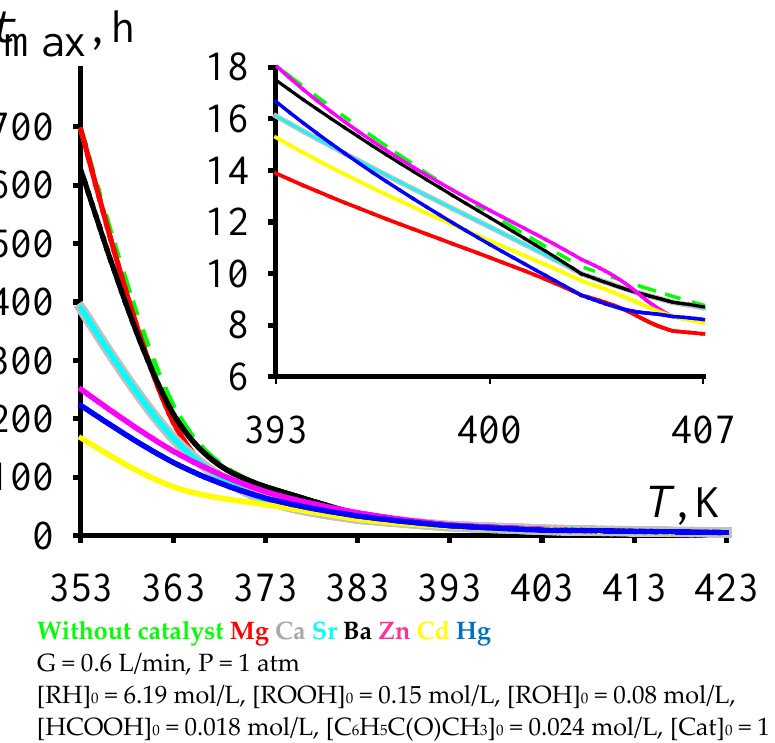
Figure 3. Time of reaching the maximum cumene hydroperoxide concentration versus the temper- ature of cumene oxidation. ture of cumene